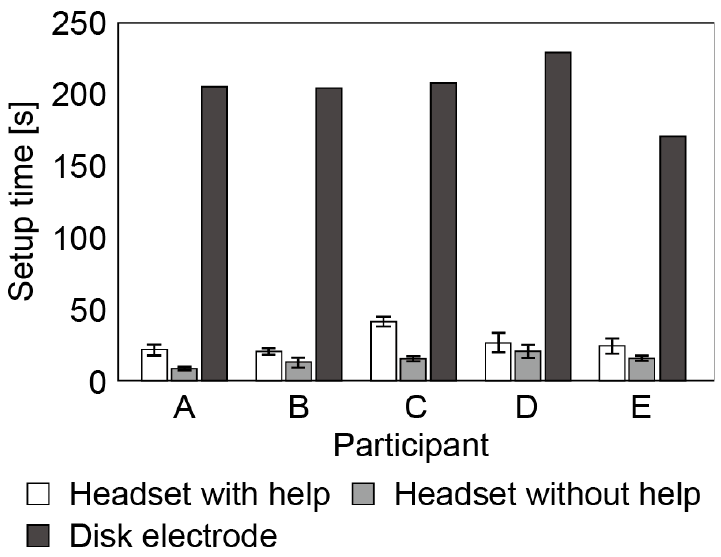
Figure 8. Setup time required to start measurement for headset with or without help from experi- menter and for disk electrodes.